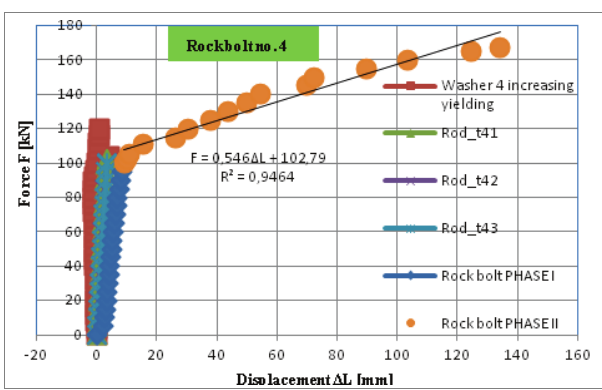
Fig. 21. The detailed loading characteristics for the components of the rock bolt support No. 3